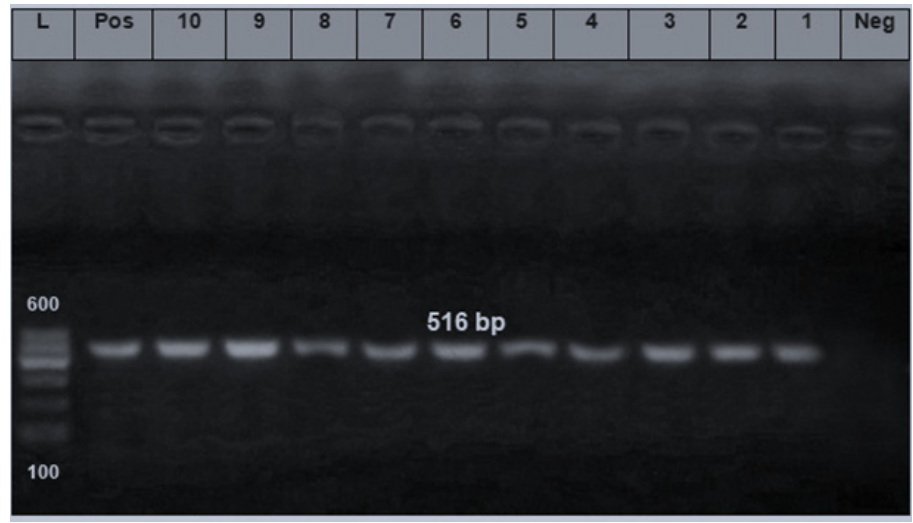
Figure 6. Agarose gel electrophoresis of bla TEM gene (516 bp). L: 100 bp ladder as molecular size DNA marker. Pos: Control positive for bla TEM gene. Neg: Control negative. Lanes from 1 to 10: Positive E. coli strains (O166, O146, O44, O111, and O26) isolated from beef shoulder and abattoir effluent for bla TEM gene.